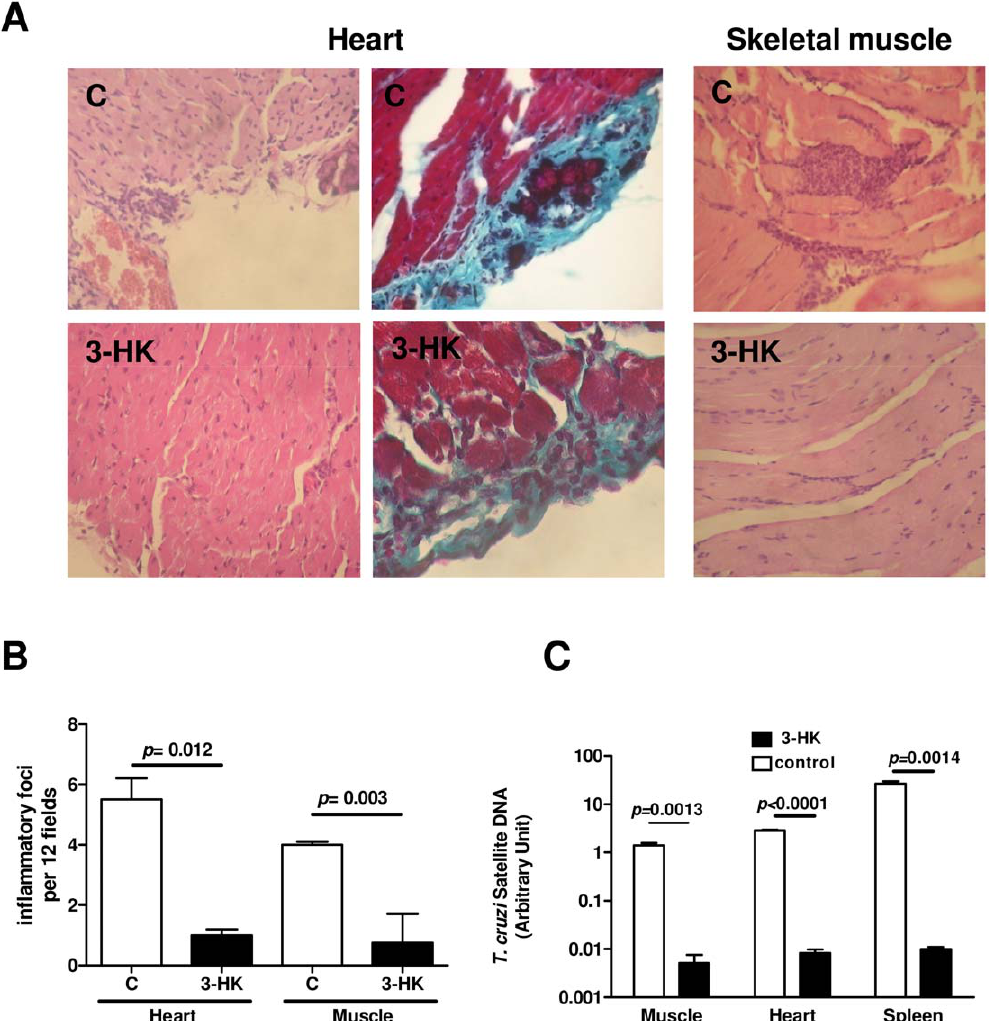
Figure 2. 3-HK treatment impairs chronic Chagas’ disease-associated inflammatory pathology. Heart and skeletal muscle sections obtained at dpi 60 from 500-Tps-infected mice, treated (3-HK) or not (C) with 3-HK, were stained with H/E and Masson trichrome staining. (A) Representative histological sections of heart (left panels) and skeletal muscle (right panel) from control (upper panels) and 3-HK mice (lower panels). Left and right panels showing focal mononuclear cell infiltrates stained with H/E. Middle panel showing collagen deposition stained with Masson trichrome stain (X100). (B) Quantitation of foci of cellular in flammatory infiltrates at 3 levels of heart and skeletal muscle from control (n=4) and 3-HK (n=4) groups, employing Axio-Vision 3.0.6 software. (C) Relative amount of T. cruzi satellite DNA in the skeletal muscle, heart and spleen from 60-day T. cruzi infected 3-HK and control mice. Murine GAPDH was used for normalization. Data are shown as mean 6 SD of triplicates, n=4 mice per group.